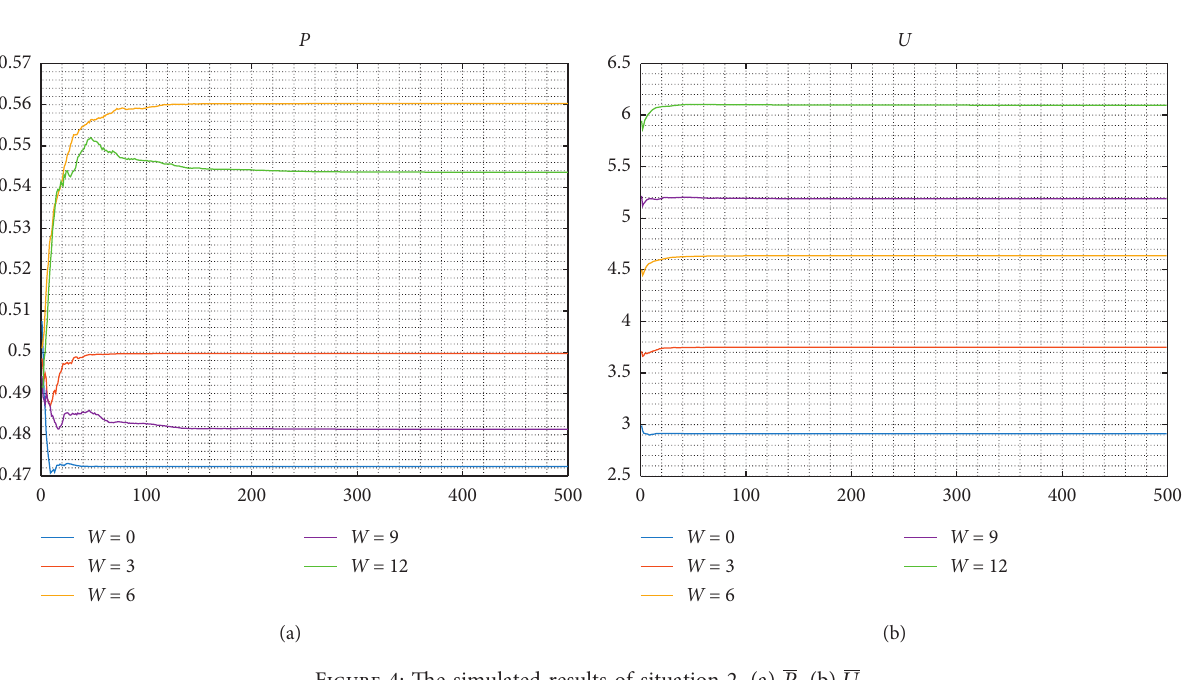
Figure 3: The simulated results of situation 1. (a) P . (b) U .